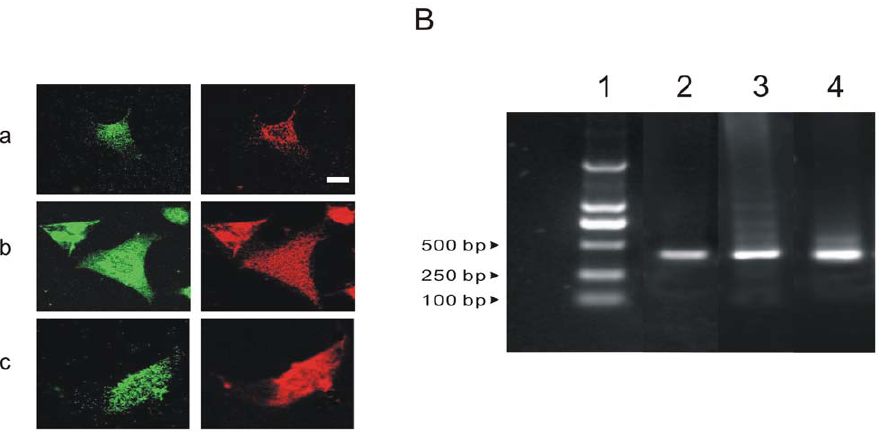
Figure 1. Expression of ANP in mouse embryonic cardiomyocytes. A : double staining of ANP (left, green) and a -MHC (right, red) in E8.5d (a), E12.5d (b), and E15.5d (c) cardiomyocytes. B : PCR product of ANP. Lanes indicate 1 marker, 2 E8.5d, 3 E12.5d, and 4 E15.5d, respectively. The scale bar is 10 micron.